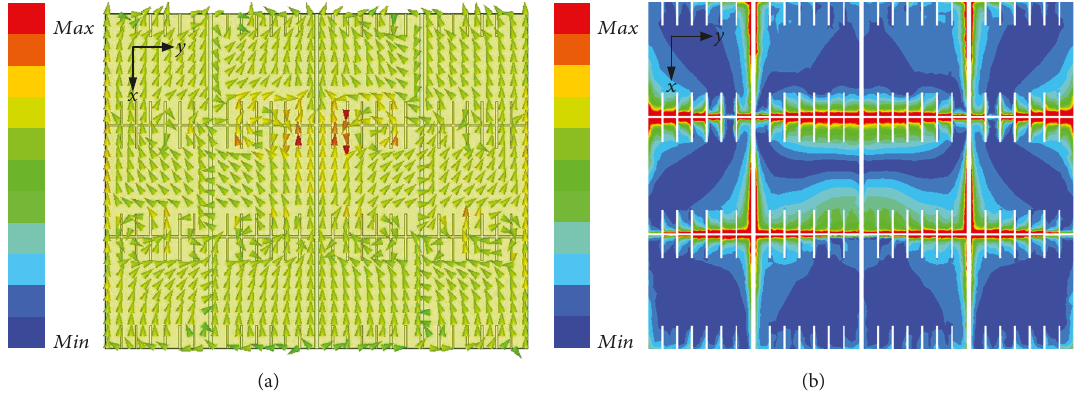
Figure 9: Simulated surface current distribution (a) and electric fi eld distribution (b) on the top surface of the PSMS at Table 1: Measured property comparison among di ff erent antennas with the proposed design. Designs